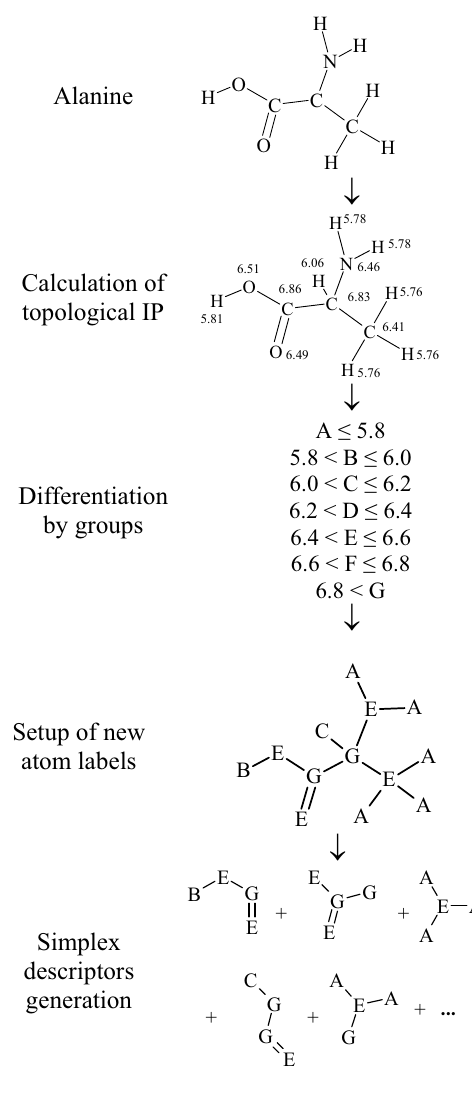
Figure 1: Example of simplex descriptor generation using atomic topological IPs for alanine at 2D